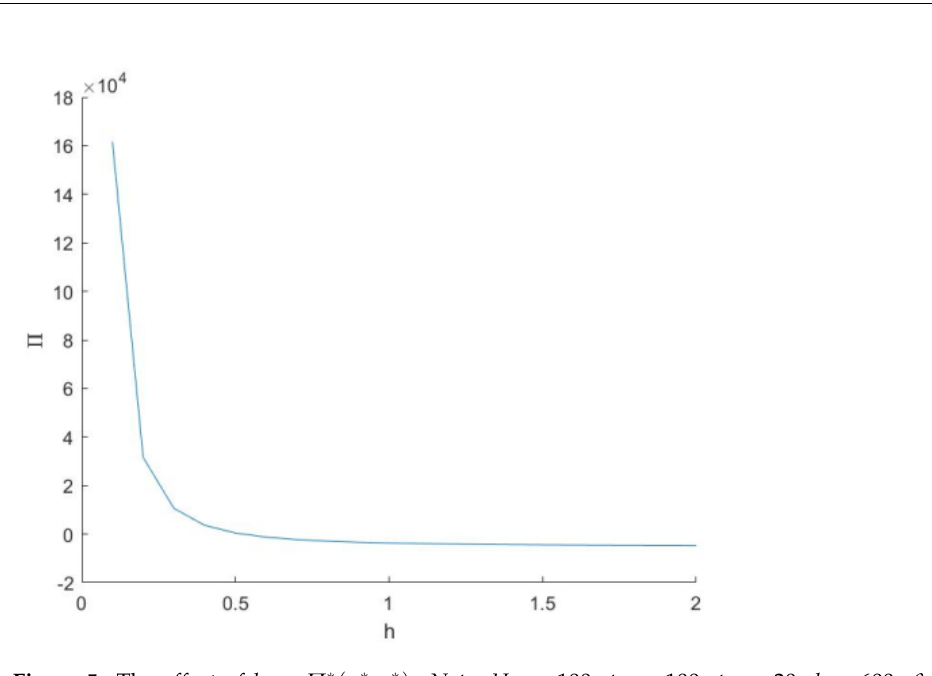
= 100, 𝑡 = 100, 𝑡 = 20, 𝑙 = 600, 𝛽 = 0.1, 𝐶 = 0 1 2 𝑎